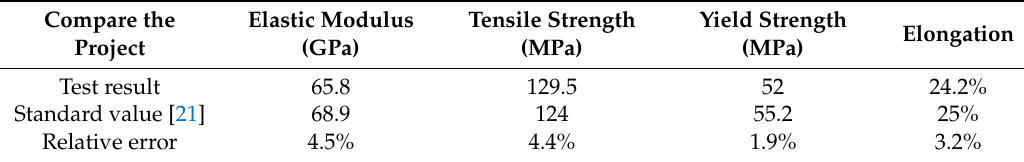
Table 3. Comparison of Biaxial Tensile Test